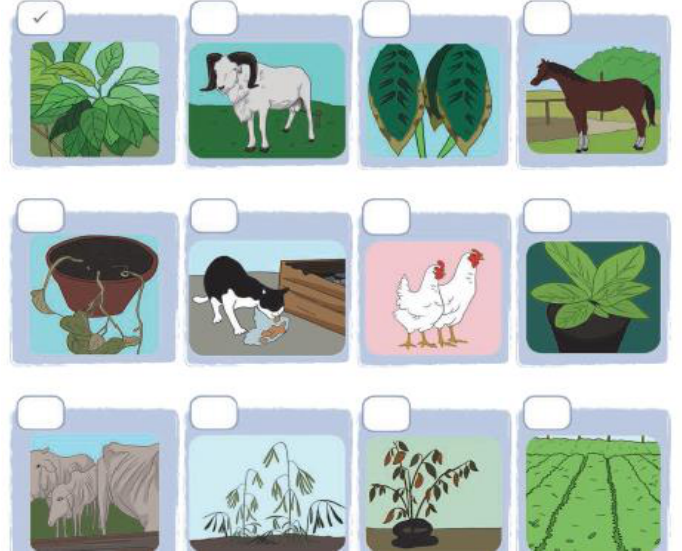
Figure 10: Choosing plants and animals that were taken care